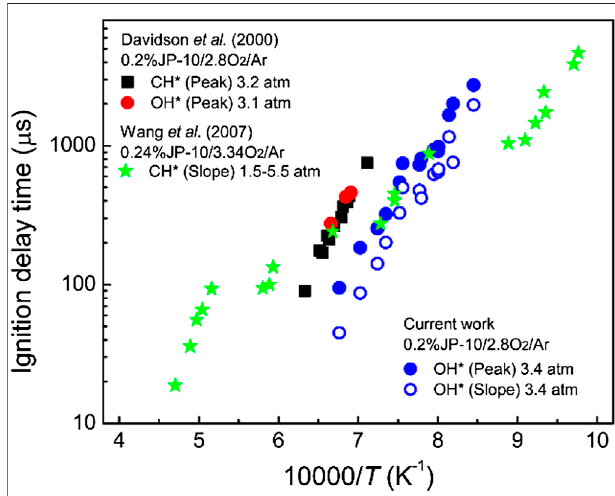
FIGURE8| Comparisonbetweenourmeasuredignitiondelaytimesand the reported values from the literature (Davidson et al., 2000; Wang et al., 2007).